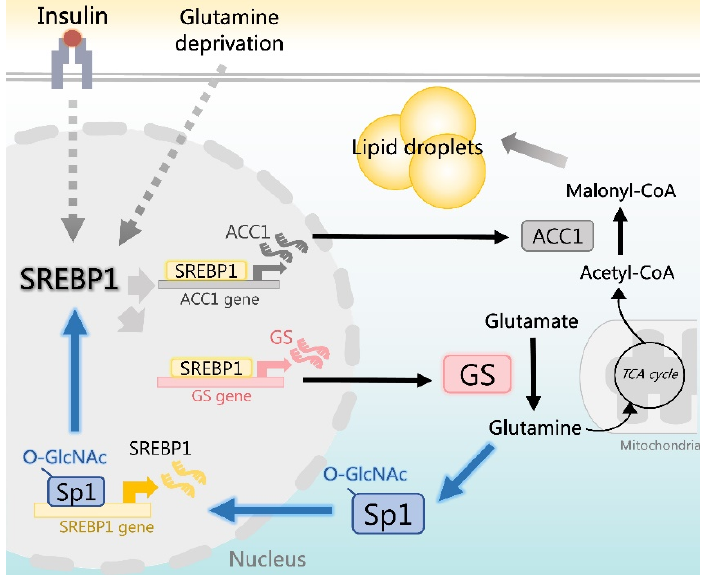
Figure 7. Schematic illustration of SREBP1-induced GS triggering a feedforward loop of O-GlcNAc- Sp1/SREBP1/ACC1 signaling that augments LD formation. SREBP1: sterol regulatory element-bind- ing protein 1; GS: glutamine synthetase; O-GlcNAc: O-linked N-acetylglucosamine; Sp1: specificity protein 1; ACC1: acetyl-CoA carboxylase 1.